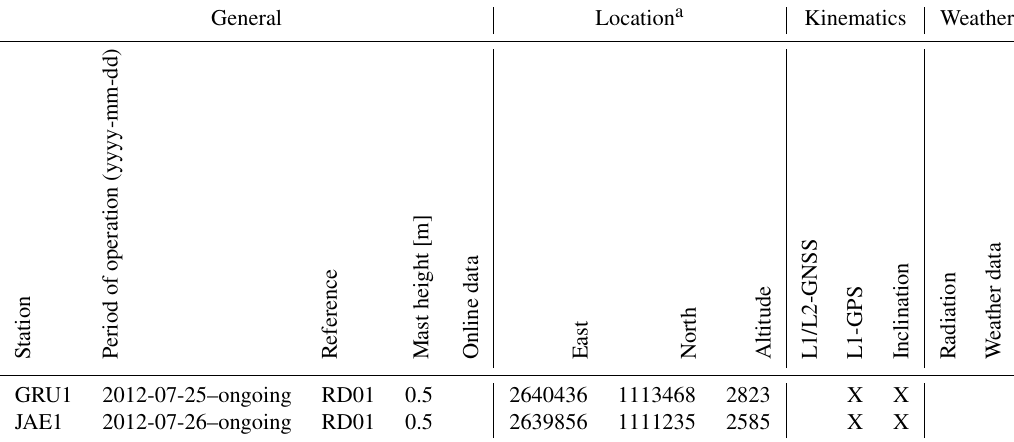
Table A4. Per position overview of the sensors in the Saas Tal field site. General Location a Kinematics